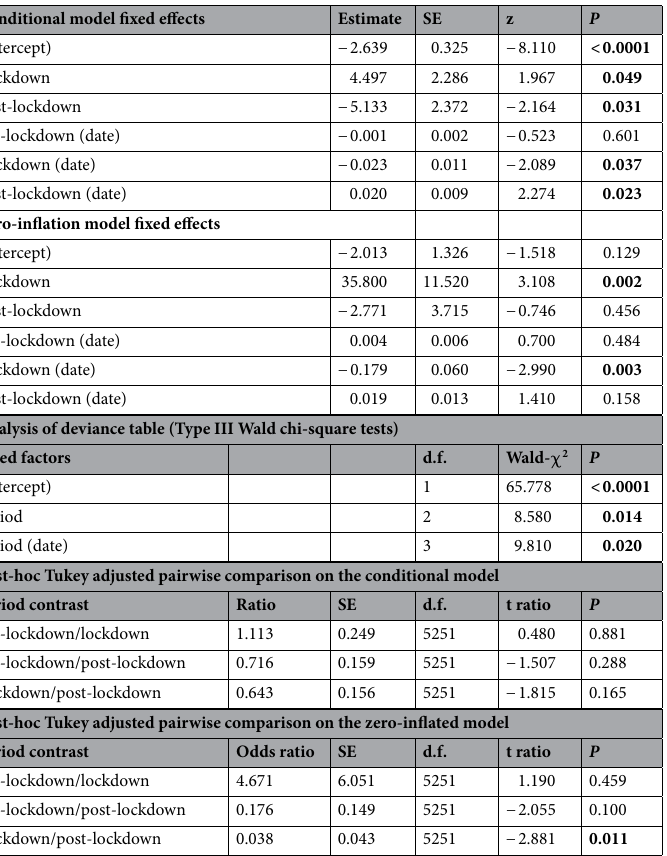
Table 1. Model summary, analysis of deviance (Wald Chi-squared tests) and Post-hoc Tukey adjusted pairwise comparisons for the model constructed to test trapping success per Multi-Catch Rodent station and